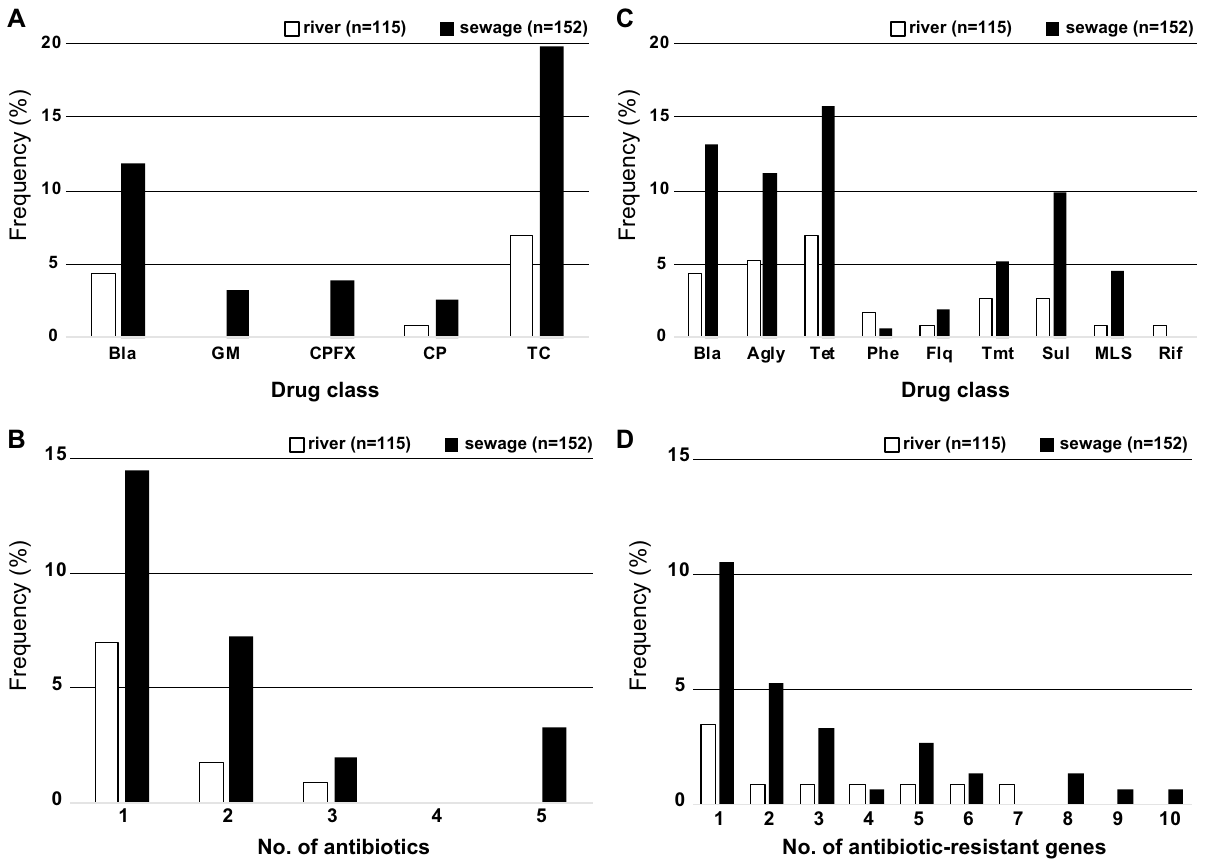
Figure 5. Prevalence of antimicrobial resistance phenotypes and genes in 283 E. coli isolates. Antimicrobial resistance profiles ( A ) and antimicrobial resistance gene content ( B ) grouped by drug class are indicated. Histograms illustrating the number of antimicrobials to which E. coli were phenotypically resistant ( C ) and genetically resistant ( D ) are shown.